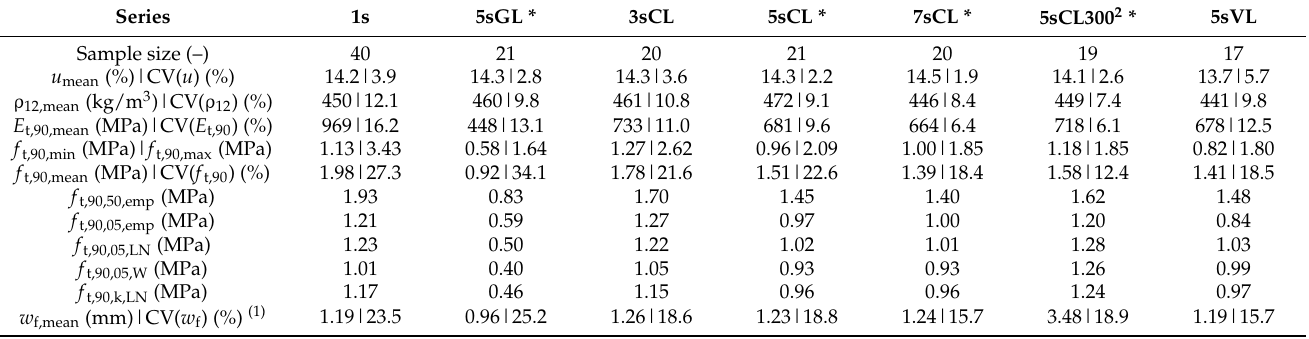
Figure 12. Box-plots with notches as 95% confidence intervals of medians for ( a ) density, ( b ) modulus of elasticity and ( c ) strength from tension out-of-plane tests. Table 7. Main statistics of moisture content, density and tensile properties out-of-plane per